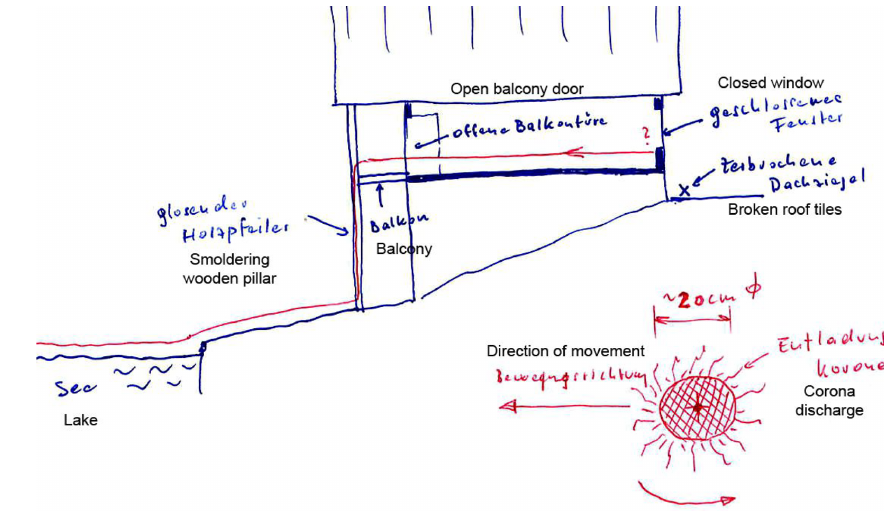
Figure 2. Sketch 1997 by Alfred Geiswinkler about his 1968 observation. Reproduction and English inserts: author.